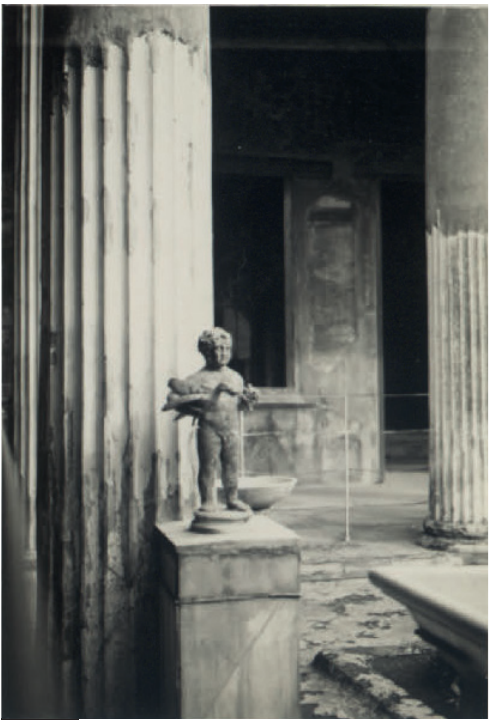
FIG. 9 G. Michelucci, Pompeii, (n. d.)